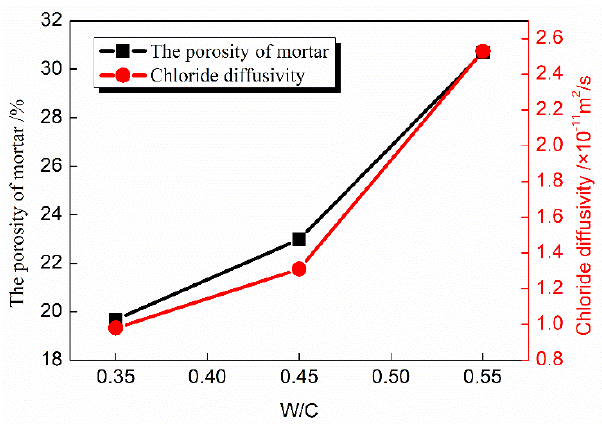
Figure 8. Variation diagram of the porosity and diffusion coefficient of the mortar.